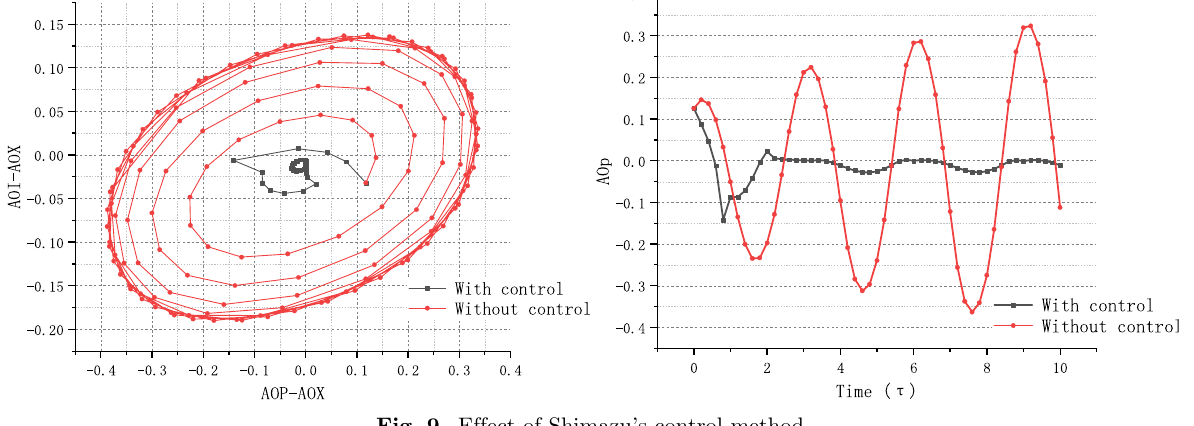
Fig. 9. Effect of Shimazu ’ s